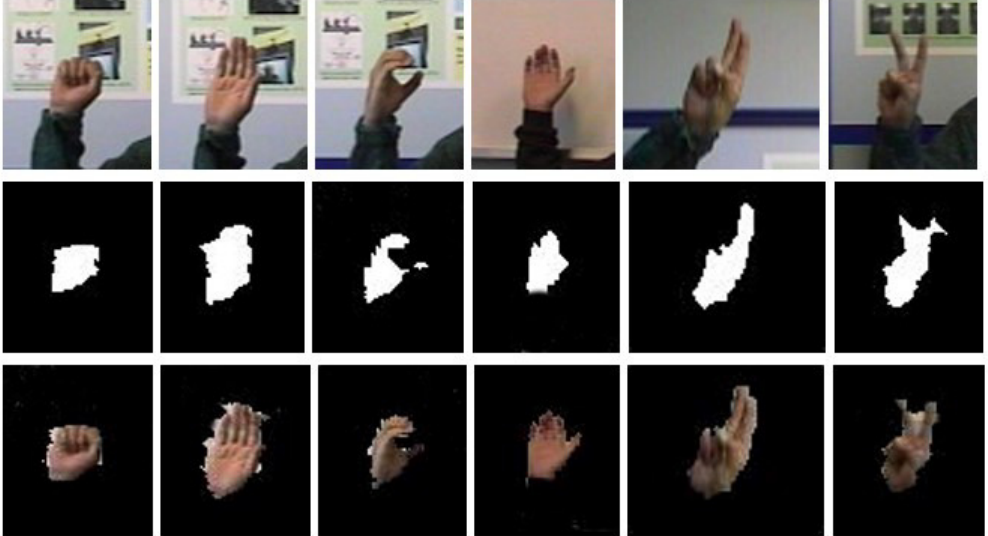
Figure 11. Sample images of hand gestures in the benchmark dataset, YCbCr image, and SkinMask segmented images (first row, second row, and third row,